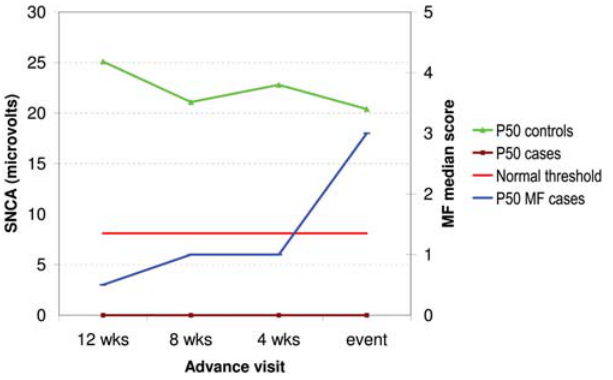
Figure 2. Trend in CMAP amplitude in the ulnar nerve above the elbow prior to a motor impairment event detected by VMT (case nerves: n=5; control nerves: n=14). ‘Cases’ are nerves with new motor impairment by voluntary muscle test (VMT) at time ‘0’; ‘controls’ are nerves without any clinically detectable sensory or motor impairment during follow-up; P50=median value; normal threshold refers to the specific parameter tested (here MNC amplitude).